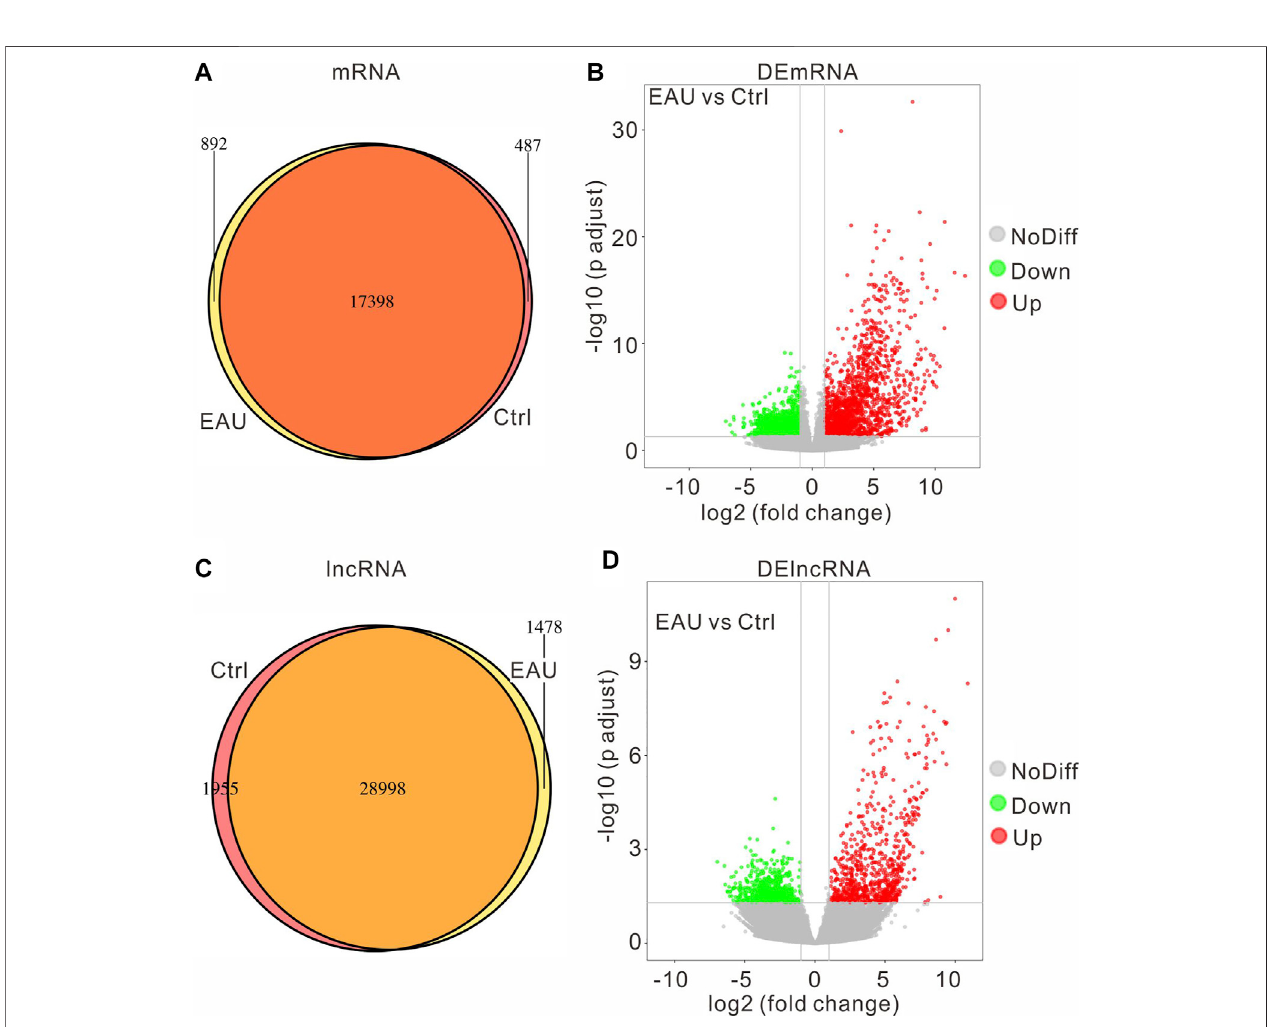
Frontiers in Genetics |